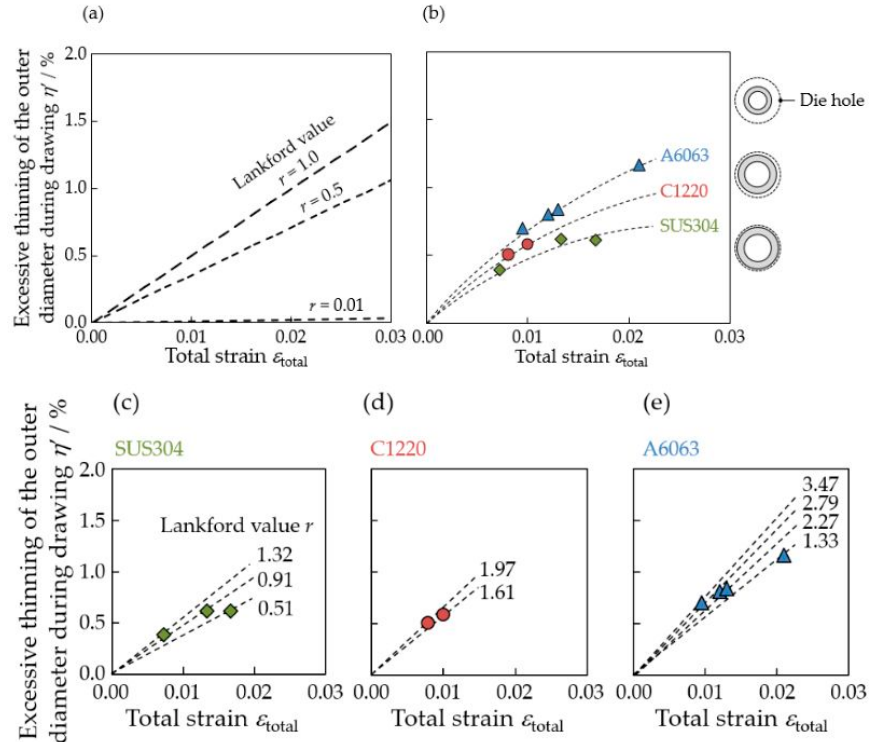
Figure 18. Theoretical relationship between the Lankford values r and the excessive thinning of the outer diameter during drawing η ’. ( a ) The excessive thinning of the outer diameter at the Lankford values r of 0.01, 0.5, and 1.0. ( b ) The excessive thinning of the outer diameter in this study of all materials in this study, including ( c ) stainless-steel, ( d ) copper, and ( e ) aluminum alloy tubes. The dotted lines or curves in Figures 18b–d indicate the eye guide.